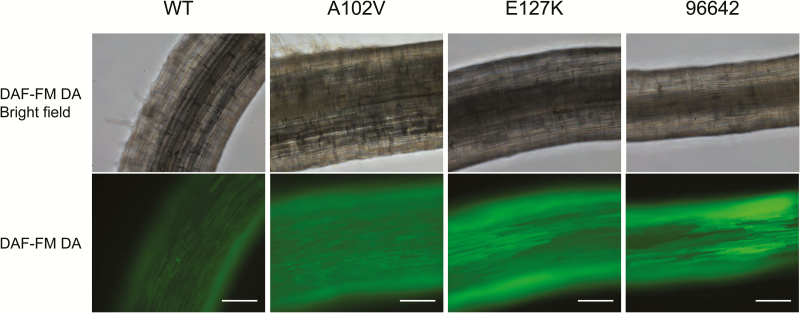
Fluorescence imaging of NO production in the roots of WT and mutant lines. Seedlings were incubated with M. loti MAFF303099 for 3h and then with DAF-FM DA for 1h. The images of the roots for all three lines were taken with a confocal microscope using identical settings. Roots incubated with mock (sterile distilled water) instead of rhizobia did not show detectable fluorescence. Scale bars=200 μm.